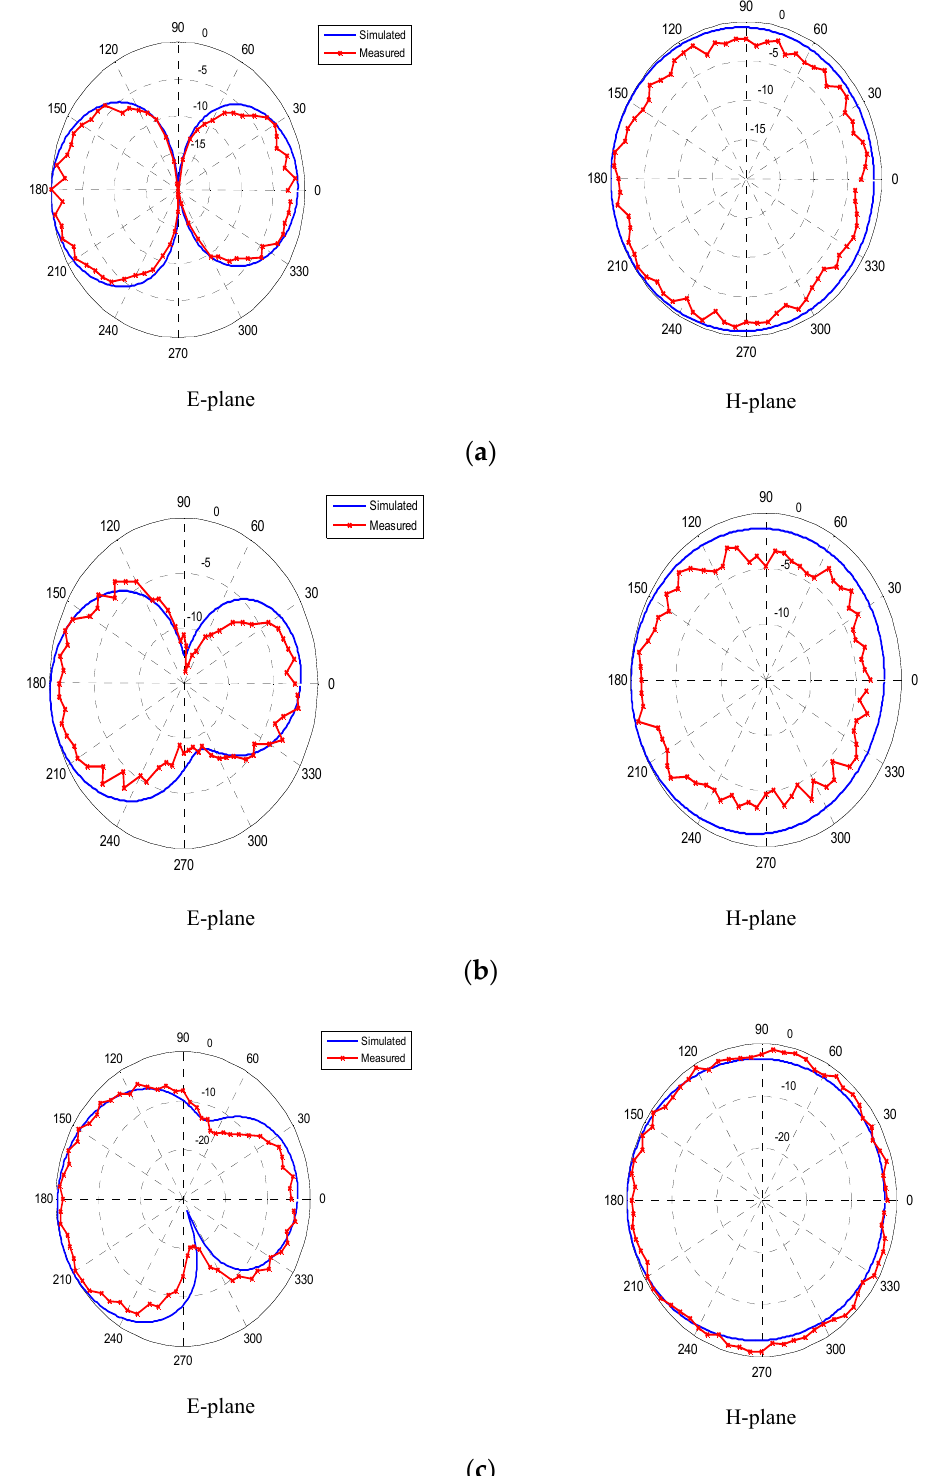
Figure 13. Radiation patterns of the proposed design at ( a ) 2.4 GHz, ( b ) 3.7 GHz, and ( c ) 5.8 GHz.